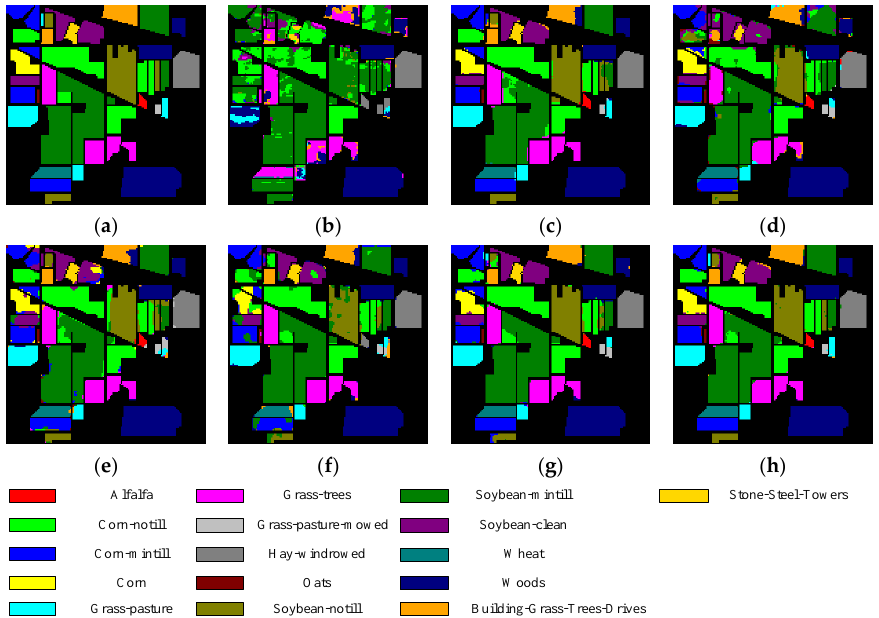
Remote Sens. 2021 , 13 , x FOR PEER REVIEW 14 of 22 Figure 5. Classification diagrams of IN datasets obtained by seven methods: ( a ) the ground truth, ( b ) SVM-RBF, ( c ) DRCNN, ( d ) ROhsi, ( e ) SSAN, ( f ) SSRN, ( g ) A2S2K-ResNet, and ( h ) DSSIRNet.